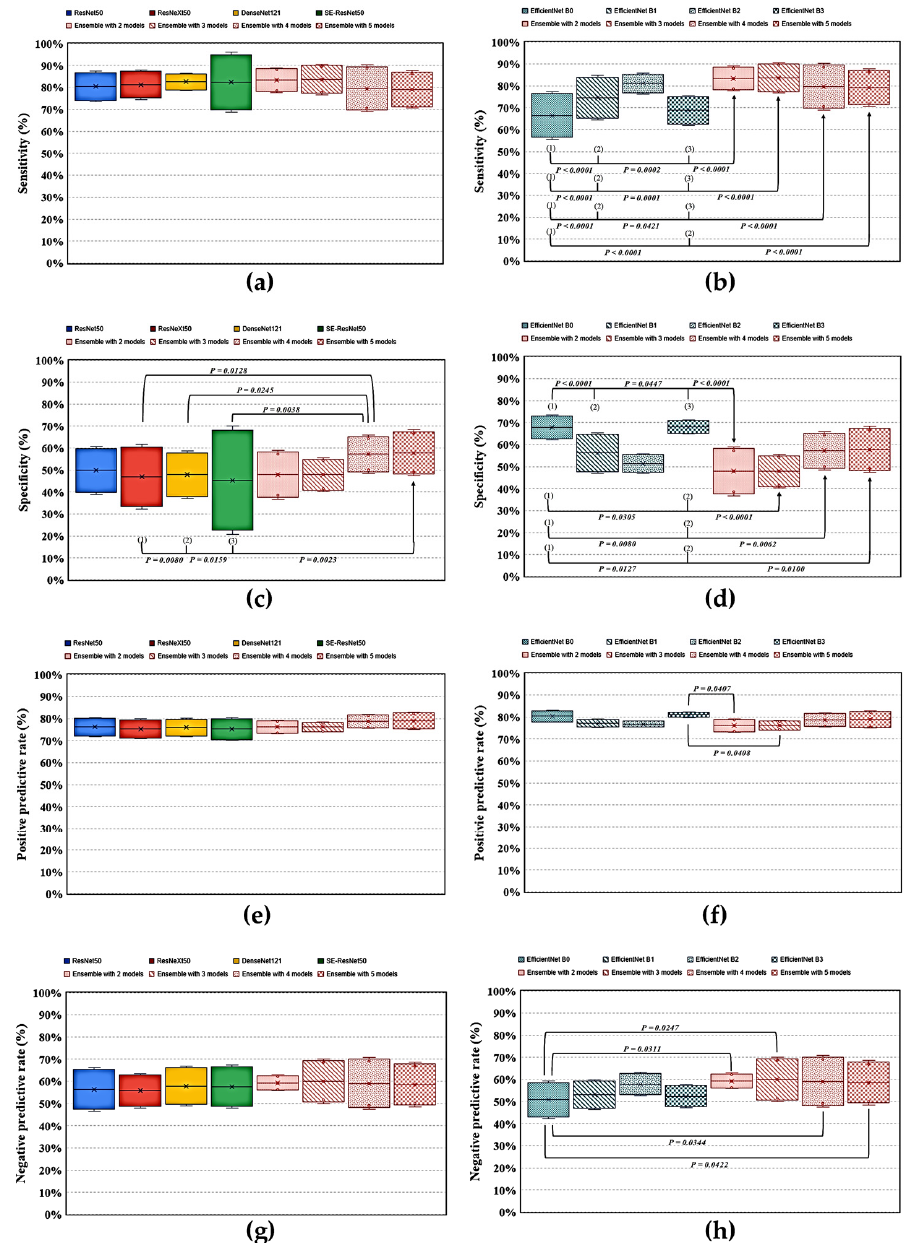
Figure 5. Comparison of the performance of ensemble models with constituent deep learning models via an external eye photo for differentiating Pseudomonas keratitis from other bacterial keratitis.